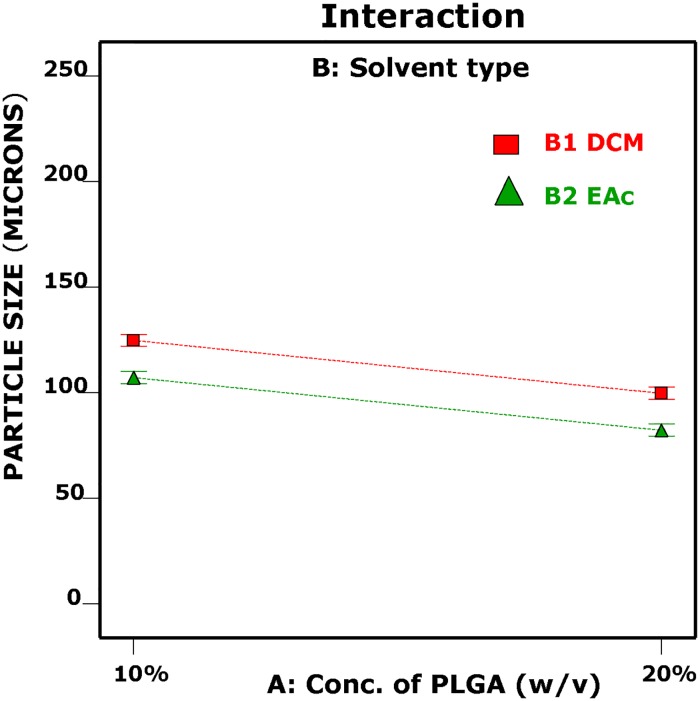
Interaction graph plot showing the effect of concentration of PLGA (w/v) and solvent type on the mean particle size (μm).